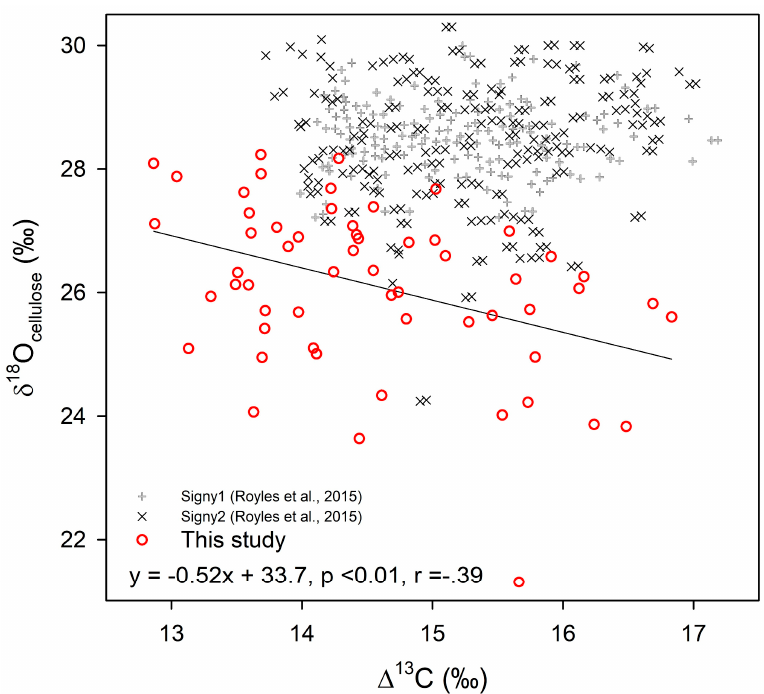
Figure 4. Correlation of δ 18 O vs. ∆ 13 C from moss C. aciphyllum cellulose of peatbank core samples from Litchfield Island, Antarctica, compared with results from Signy Island [30]. There was a significant negative relationship ( p < 0.01, r = − 0.39) for our results.